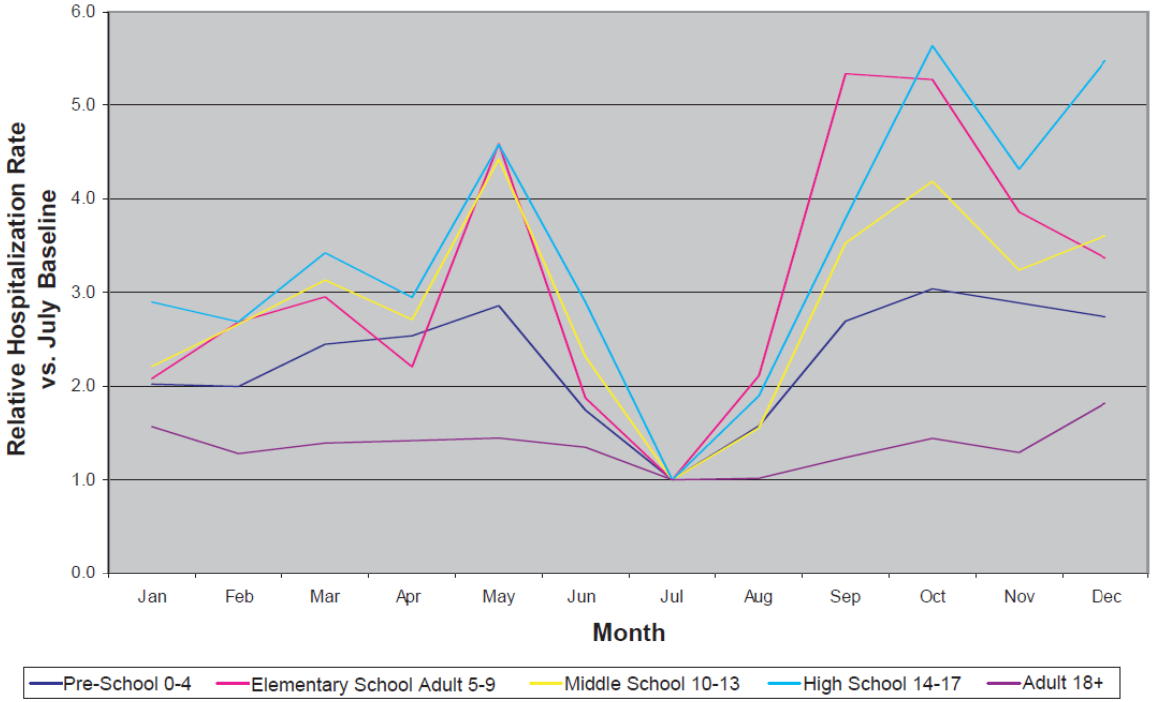
Figure 1. Seasonal trends in asthma hospitalization related to the presence of aeroallergens. Source: New Jersey Department of Health and Senior Services, 2003–2004; NJ Hospital Discharge file (UB-92) ICD-9-CM code: Asthma 493.0–493.9 as the primary diagnosis